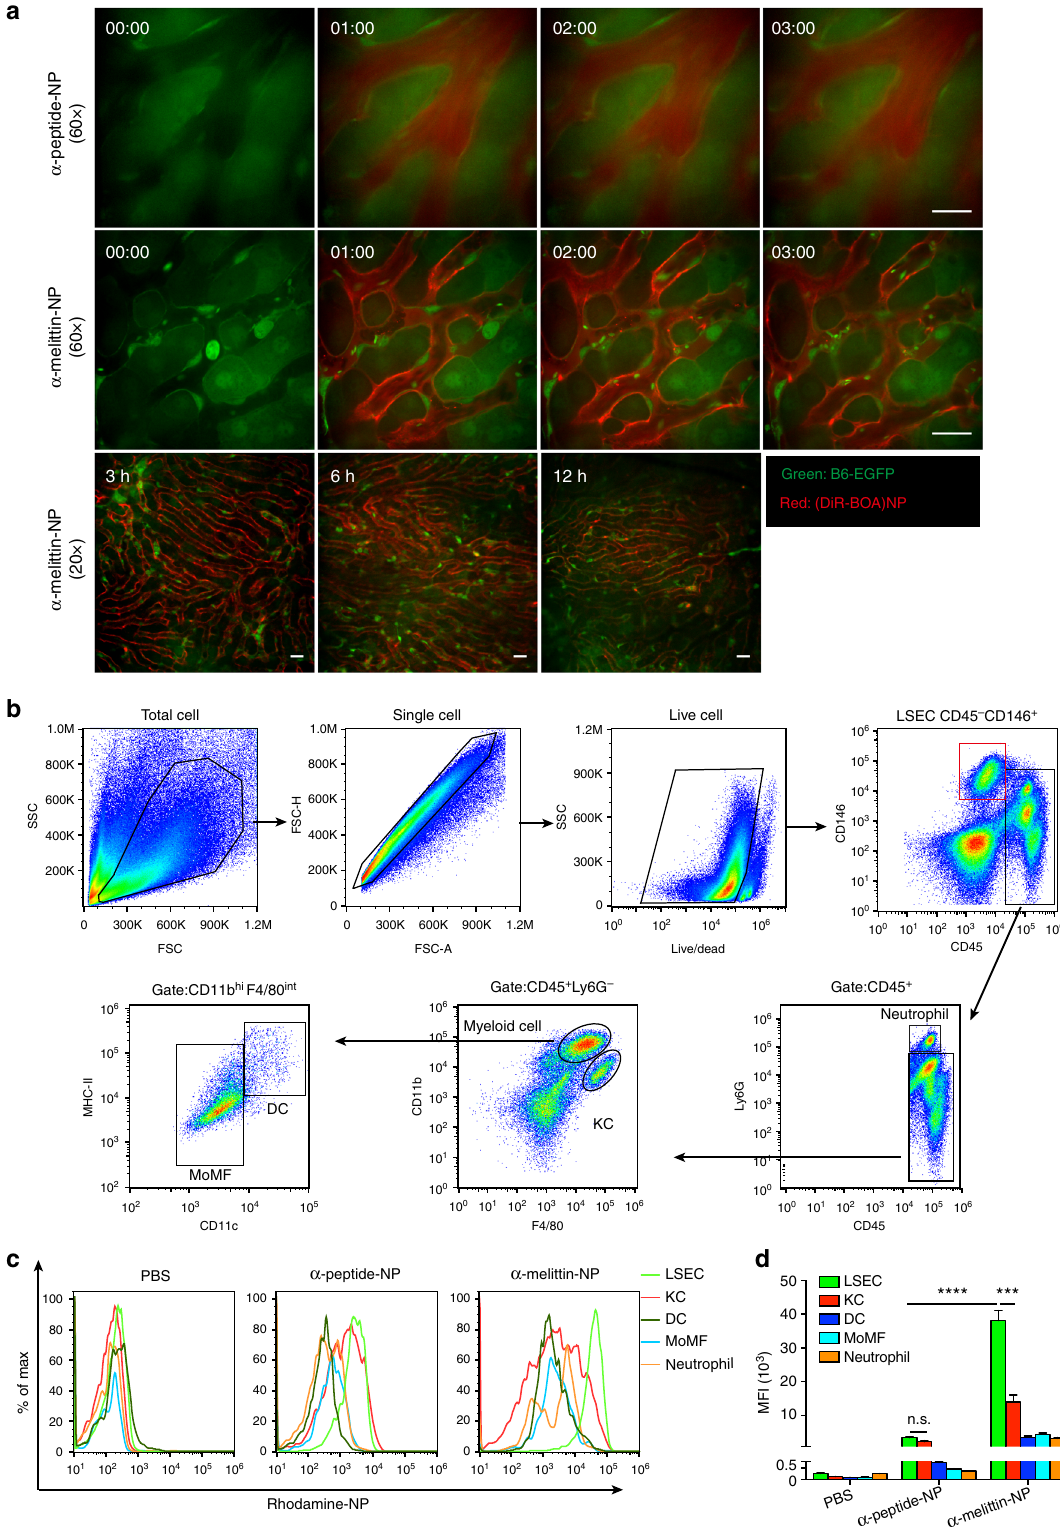
α -melittin-NPs is highest in LSECs, compared to KCs (2.7-fold), further divided into DCs (CD11c hi MHC-II hi ) and MoMFs DCs (10.6-fold), MoMFs (8.6-fold), and neutrophils (11-fold) (CD11c int MHC-II low ) (Fig. 1b). Figure 1c shows representative FCM histograms for the fl uorescent intensity of nanoparticle (Fig. 1c, d). LESCs also displayed non-speci fi cally phagocytic within the cell subsets in the liver. The quanti fi cational data of the abilities, similar to those of KCs, which took up a certain number mean fl uorescence intensity (MFI) show that the ability to uptake of α -peptide-NPs. Due to the melittin peptide sequence in NATURE COMMUNICATIONS| (2019) 10:574